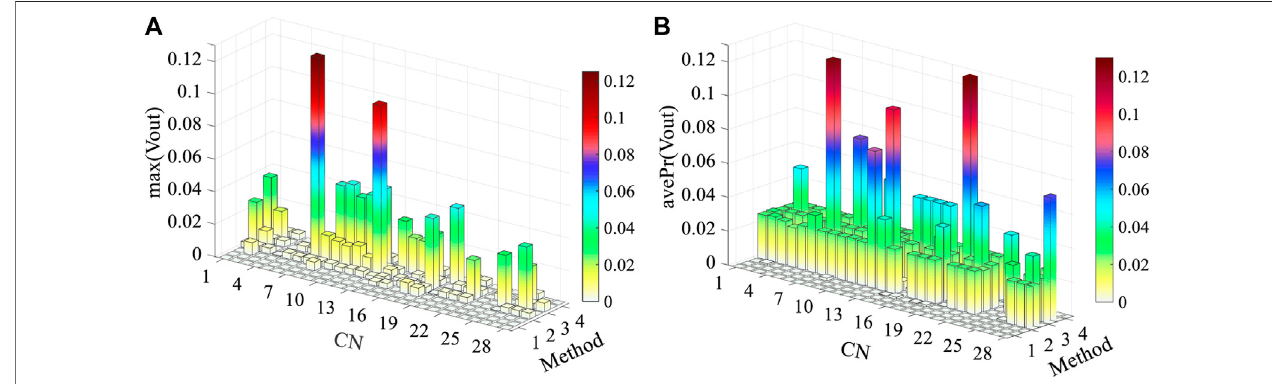
FIGURE 9 | Out-of-limit situation of voltage magnitude. (A) Maximum out-of-limit situation of voltage magnitude. (B) Average out-of-limit situation of voltage magnitude.